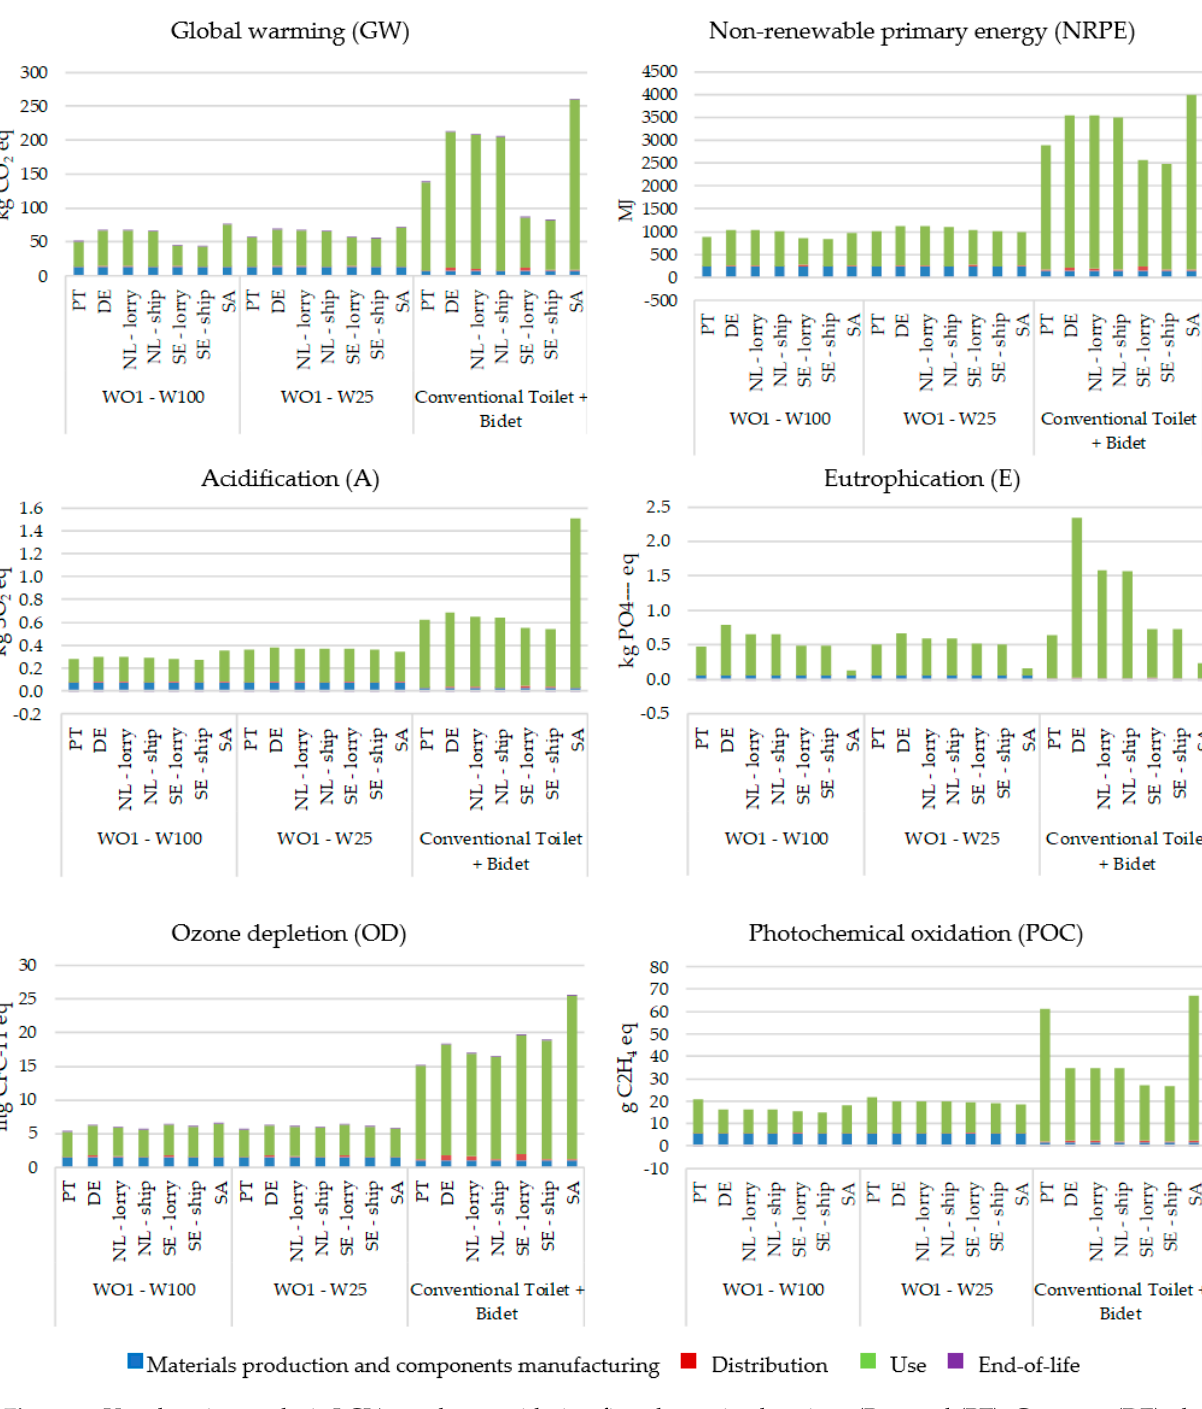
Figure 5. User location analysis LCIA results, considering five alternative locations (Portugal (PT), Germany (DE), the Netherlands (NL), Sweden (SE) and Saudi Arabia (SA)) and two transportation modes (lorry and